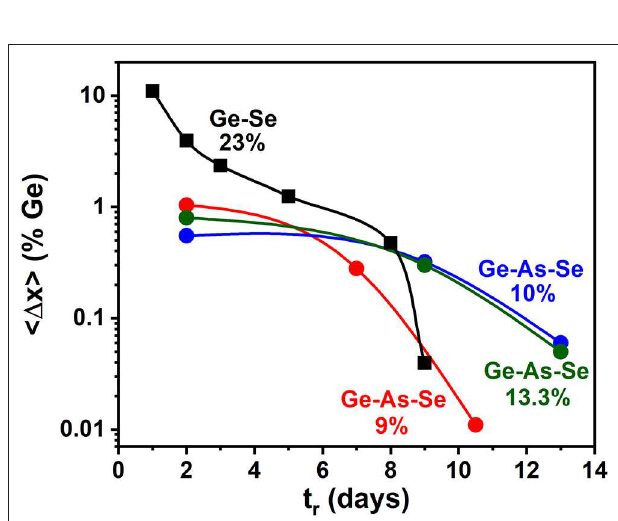
FIGURE 2 | Observed reduction in the Ge variance <1 × > Ge of the Ge x As x Se 100 − 2x glasses as a function of alloying time t r in days at indicated compositions x when probed at a 50 µ m resolution determined by the laser spot size. Glass homogeneity steadily increases as <1 × > Ge decreases by almost two orders of magnitude upon alloying the starting materials for